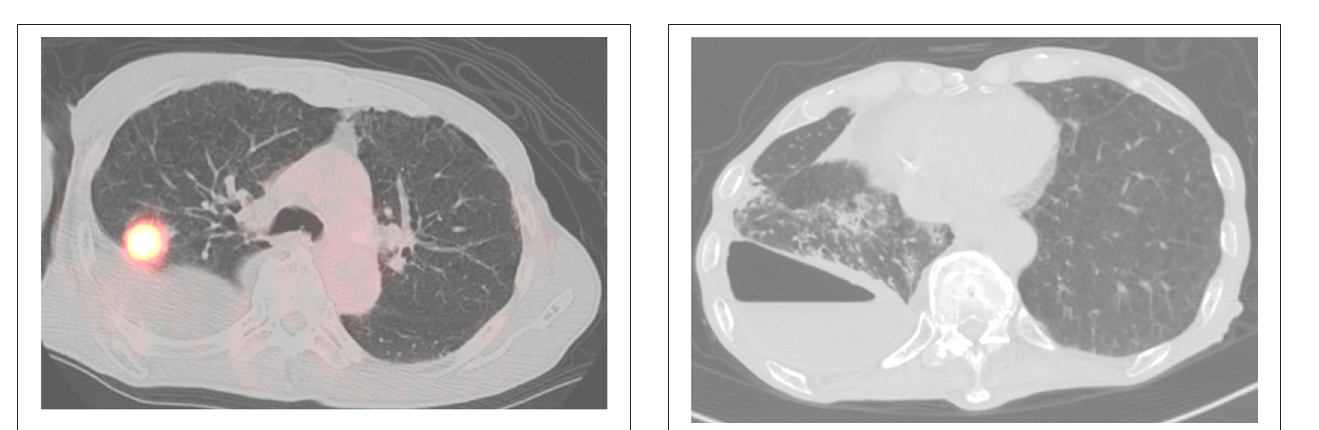
FIGURE 1 | PET-CT scan showing no FDG uptake in the pleura.